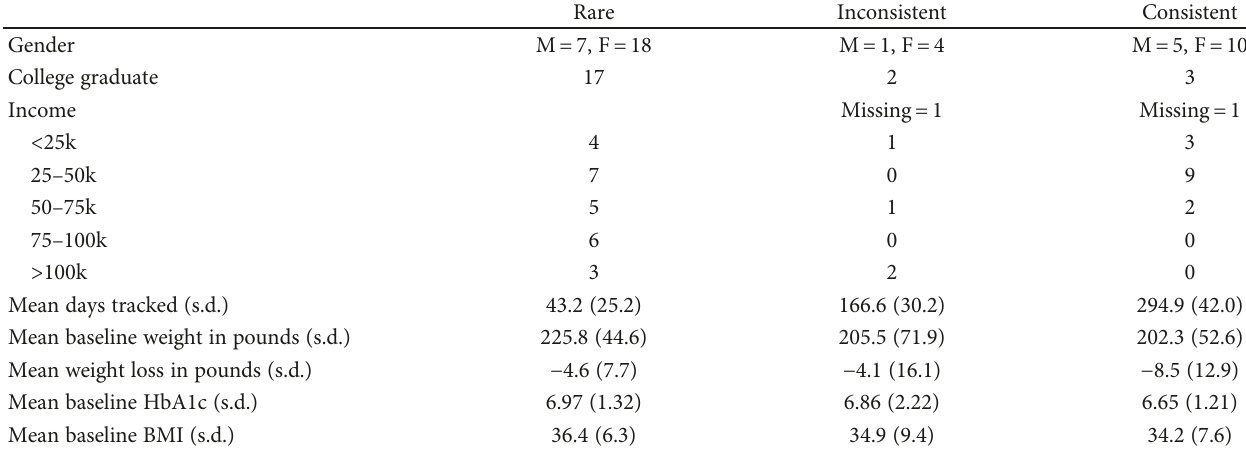
Table 1: Descriptive statistics across the 3 tracking groups: rare ( < 33% of days tracked, n = 25 ), inconsistent (33 – 66%, n = 5 ), and consistent ( > 66%, n = 15